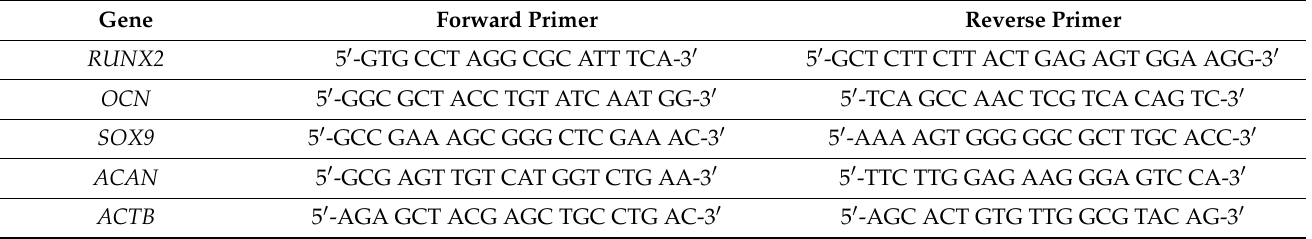
Table 1. List of primers used for PCR